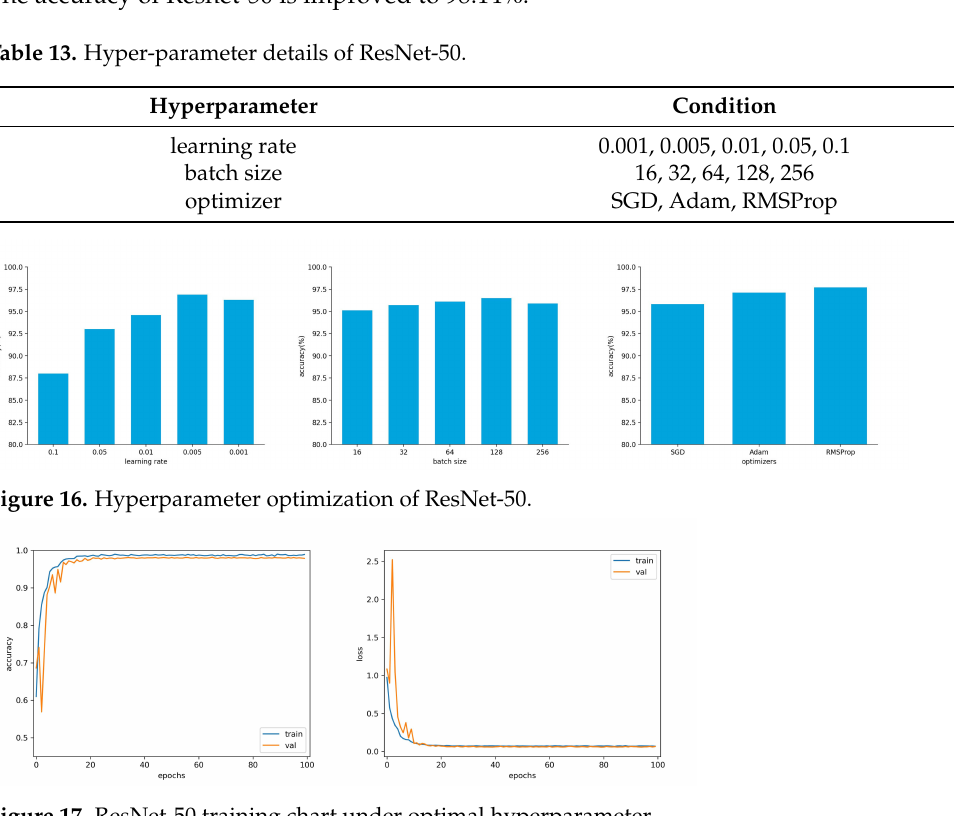
Figure 17. ResNet-50 training chart under optimal